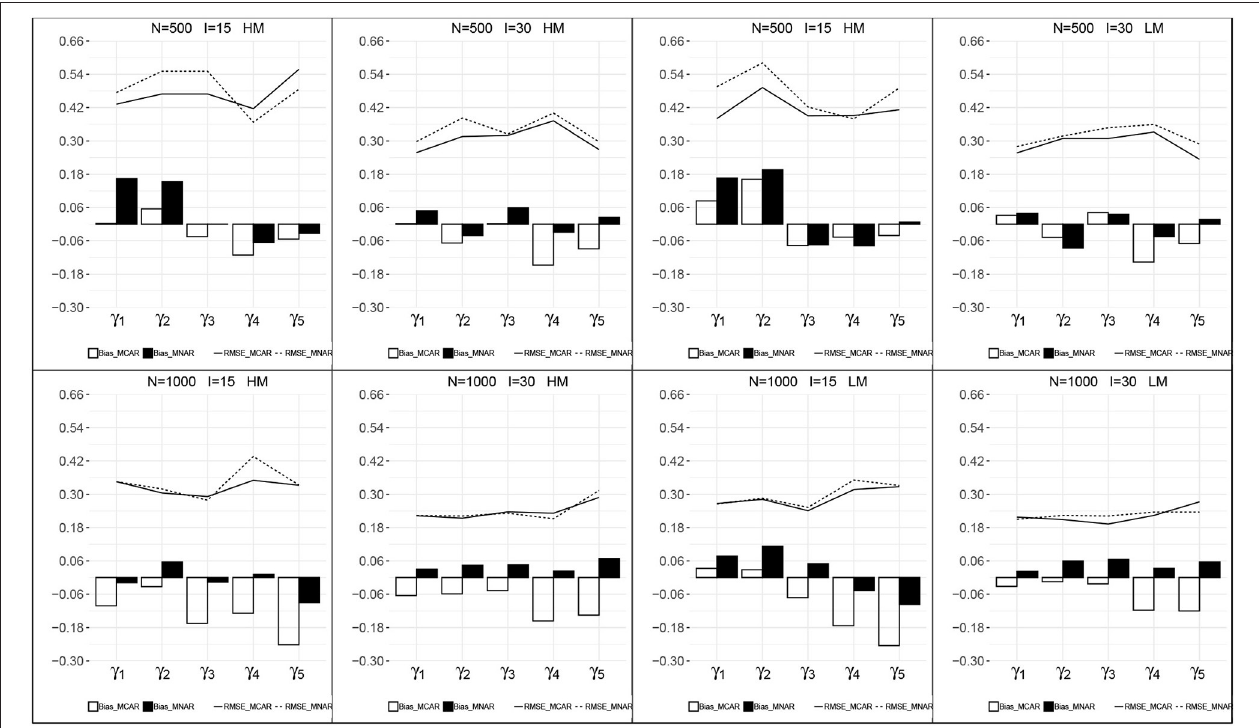
FIGURE 4 | Recovery of the attribute slope parameters. HM, high missingness; LM, low